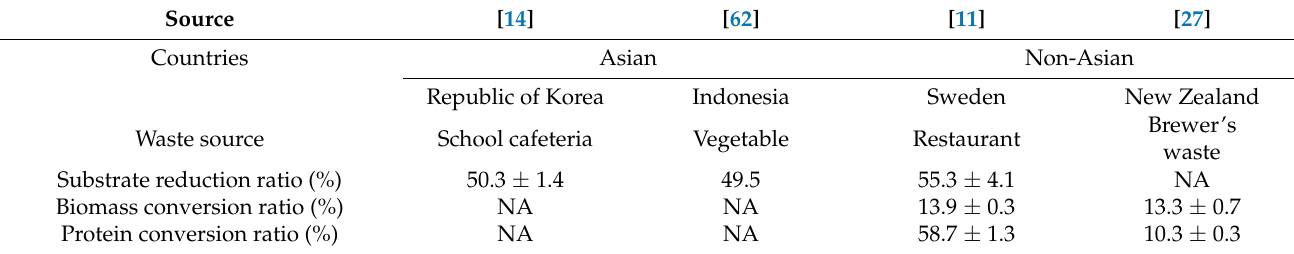
Table 2. Summary of treatment efficiencies of various food wastes by BSFL. Substrate reduction ratio: ratio between the amount of substrate reduced after the treatment and initial amount of substrate; biomass conversion ratio: ratio between total dry matter weight of prepupae and that of prepupae plus substrate; protein conversion ratio: ratio between total amount of protein in dry matter of prepupae and that of prepupae plus substrate. NA: Not available. Protein conversion ratio